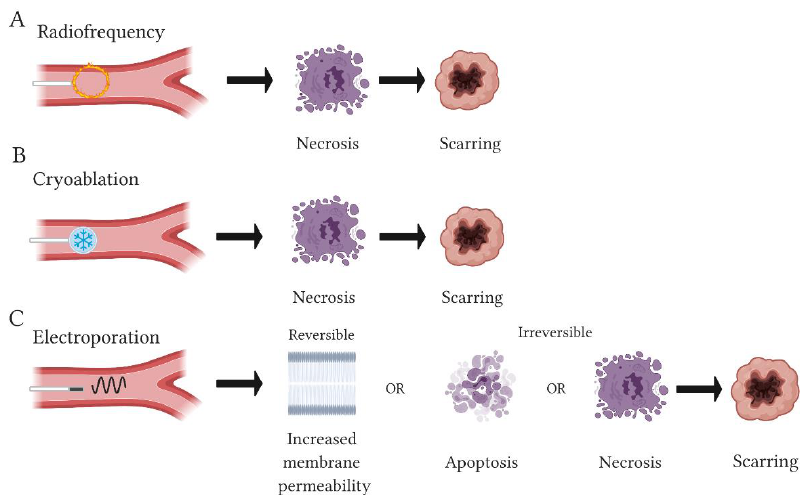
Figure 2. Effects of thermal and non-thermal energies. Diagram highlights the differing outcomes exhibited post-ablation between radiofrequency ( A ), cryoablation ( B ) and electroporation (EPo) ( C ) modalities. Radiofrequency and cryoablation can induce necrosis upon application which is fol- lowed by scarring with the intention to break arrhythmic circuits. Meanwhile, EPo increases membrane permeability which can lead to apoptotic or necrotic cell death, ultimately resulting in